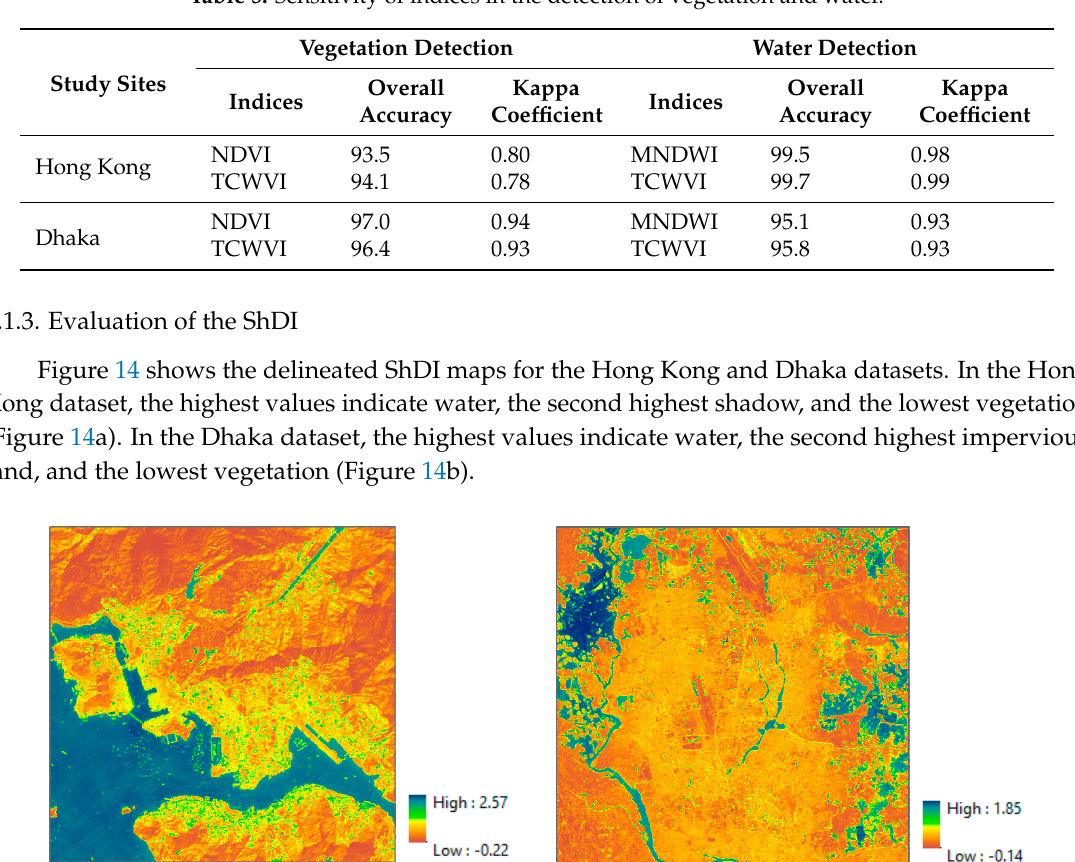
Figure 14. ShDI-based maps of the two study sites: ( a ) Hong Kong and ( b ) Dhaka.